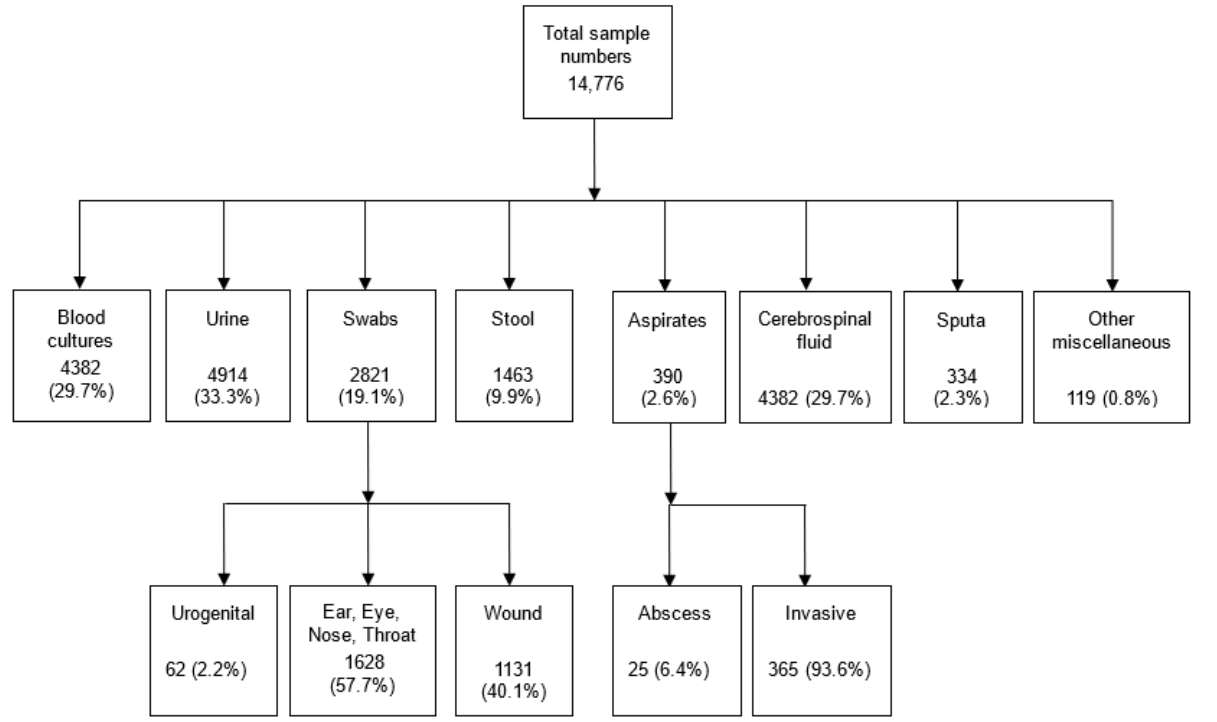
Figure 1. Flow chart showing distribution of the different samples. Results of 182 (4.2%) clinically significant blood cultures (Figure 2a) were further ana- lyzed and the leading cause of bacteremia were E. coli ( n = 40) and S. aureus ( n = 39) responsible for 22.0% and 21.4% respectively (Figure 2b). This was followed by non-typhoidal Salmonella (NTS) ( n = 16), S. pneumoniae ( n = 15), Enterococcus species ( n = 15), and Pseudomonas species other than P. aeruginosa ( n = 10) (Table 1). From urine samples, 9.0% were confirmed clinically relevant ( n = 442) (Figure 2a). Among the causes of UTI, 55.4% were E. coli ( n = 245) and 12.7% were K. pneumoniae ( n = 56) (Figure 2b) followed by other coliform bacteria ( n = 31), Candida species ( n = 26), Enterococcus faecalis n = 16 and Streptococcus agalactiae n = 14 (Table 2).